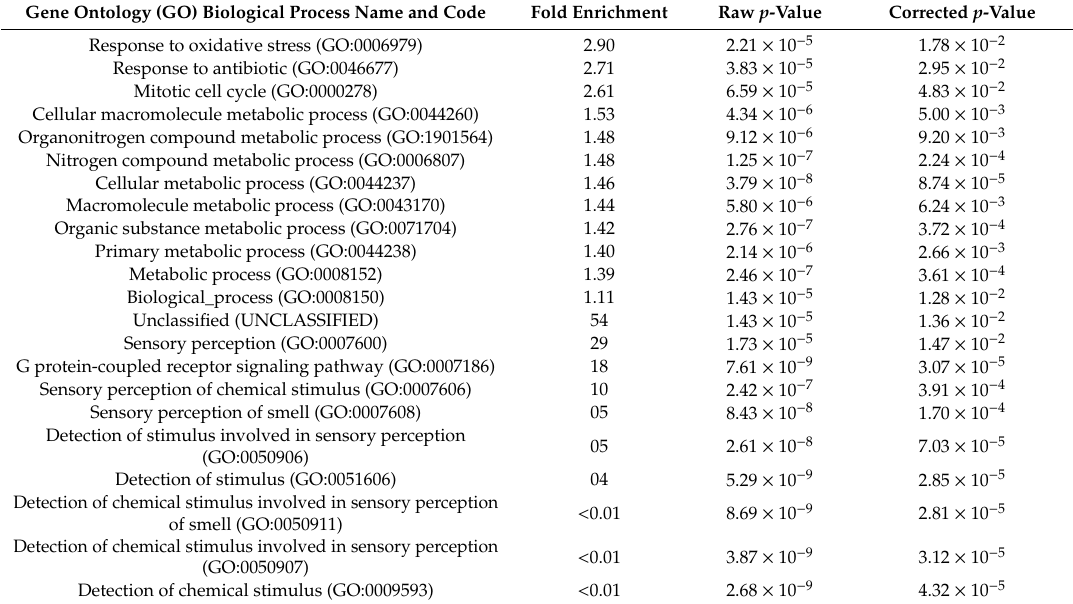
Table 1. Gene ontology biological process enrichment analysis of the di ff erentially expressed transcripts upon Decorin treatment. Fold enrichment shows the ratio of the number of the uploaded genes compared to expected number according to reference list. Fold enrichment value over 1 denotes overrepresentation, meanwhile below 1 denotes underrepresentation of the particular process, respectively. Raw p -values were obtained by Fisher’s exact test. Corrected p values were calculated according to Benjamini-Hochberg correction (false discovery